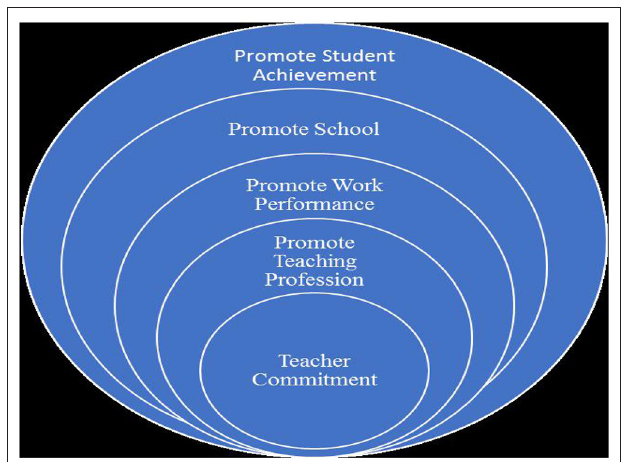
FIGURE 1 | Teacher